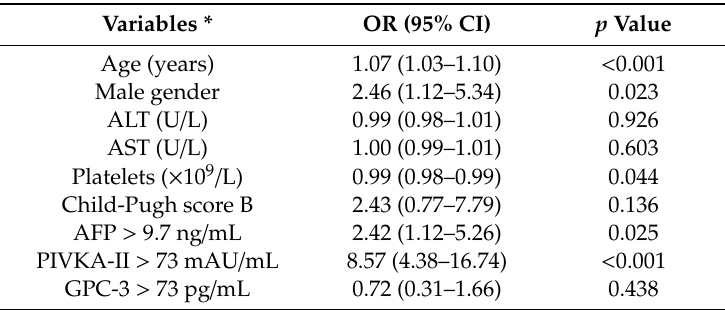
Table 4. Multivariate analysis for factors associated to HCC.